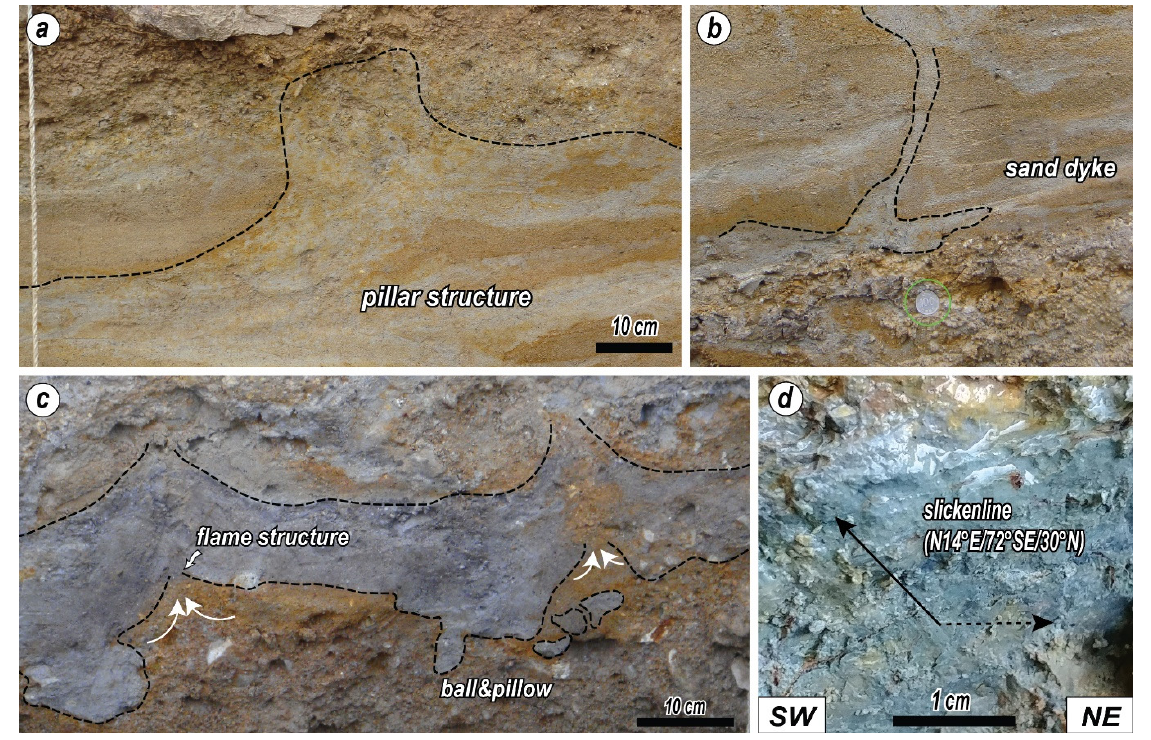
Figure 10. Photograph showing features in a section of the trench. ( a ) Pillar structure and ( b ) sand dyke in unit E. ( c ) Flame and ball and pillow structures in unit G. ( d ) Slickenline on the F6 fault surface indicating dextral reverse faulting.